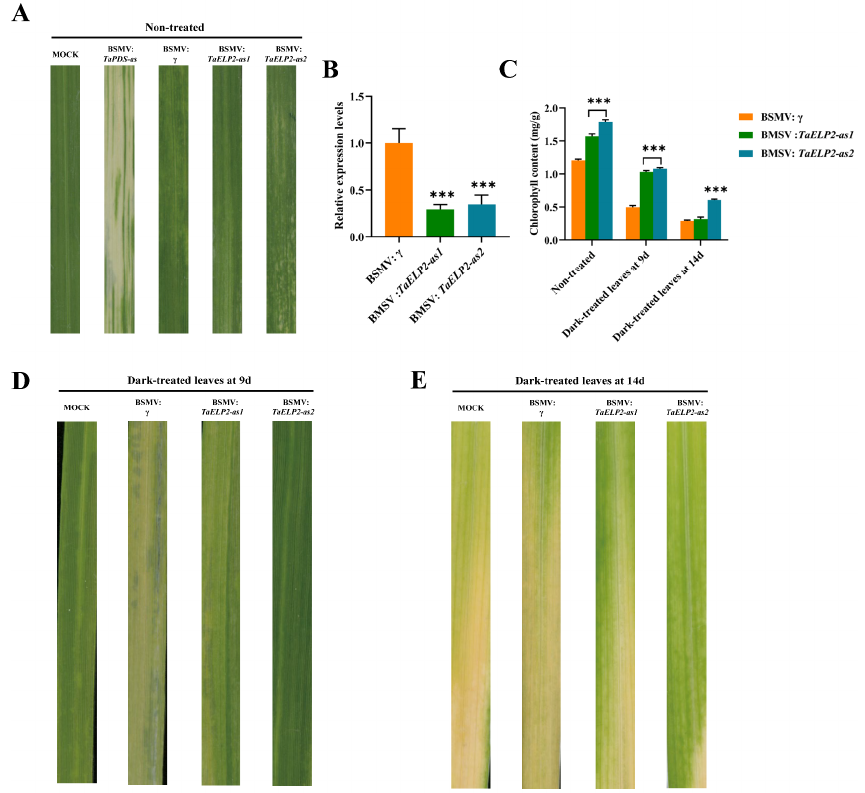
Figure 8. BSMV-mediated gene silencing of TaELP2 delays dark-induced leaf senescence in wheat. ( A ) Virus symptoms after ten days of BSMV virus inoculation. ( B ) Silencing efficiency analysis of TaELP2 in BSMV-inoculated leaves. The relative expression of TaELP2 was analyzed by using qRT- PCR and calculated using the comparative threshold (2 −ΔΔCT ) method. Data normalized with the expression of wheat elongation factor, TaEF-1α . The BSMV-γ was used as a control and standardized with 1. Values represent the mean ± SE from three independent biological samples. Triple asterisks ( p < 0.001) designate significant differences from BSMV-γ using the Student’s t -test. ( C ) Changes in chlorophyll content of BSMV-infected wheat leaves after dark treatment at 0, 9, and 14 days. Values represent the mean ± SE from three independent biological samples. Triple asterisks ( p < 0.001) designate significant differences from BSMV-γ using the Student’s t -test. ( D , E ) Phenotypes of wheat leaves after dark treatment at 9 and 14 days, respectively.